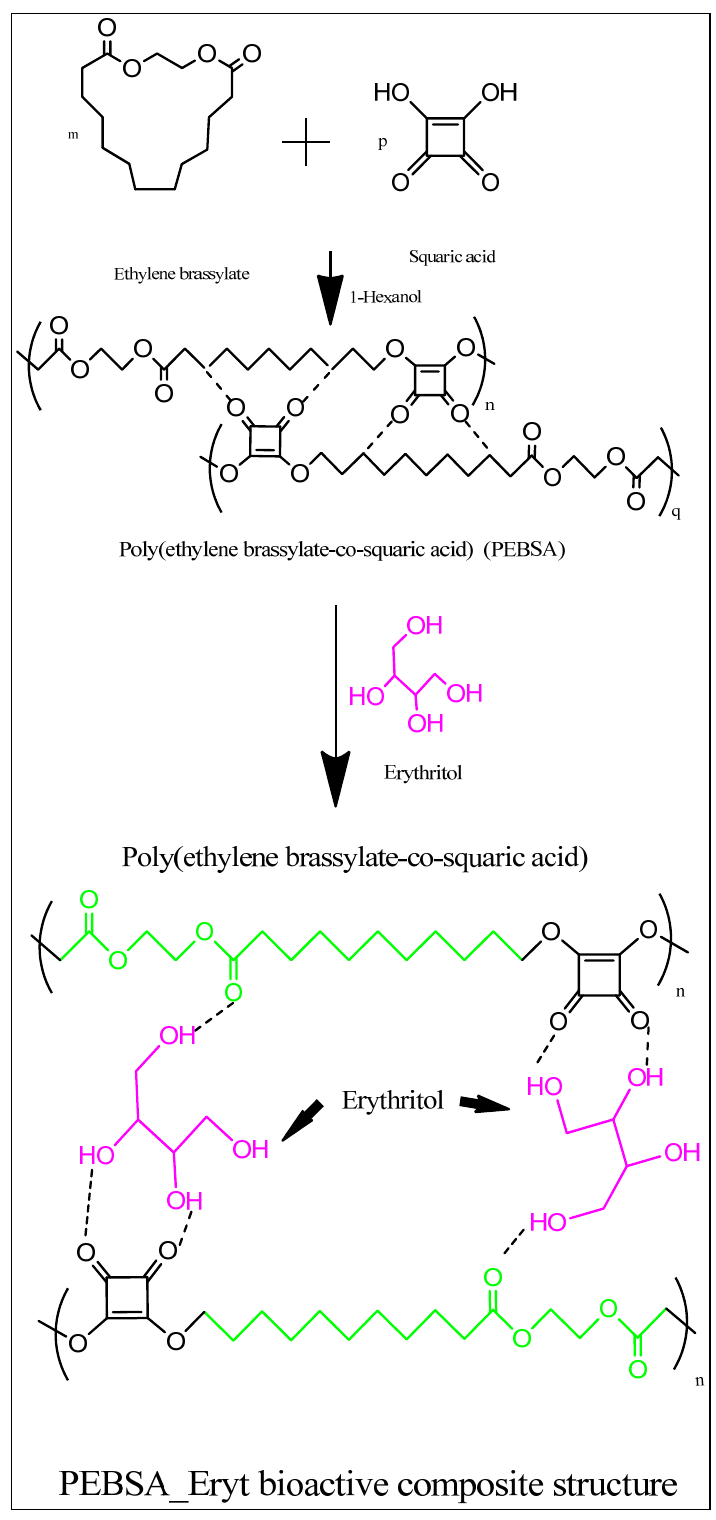
Figure 5. Schematised illustration of the synthesis of PEBSA and PEBSA_Eryt bioactive structure.